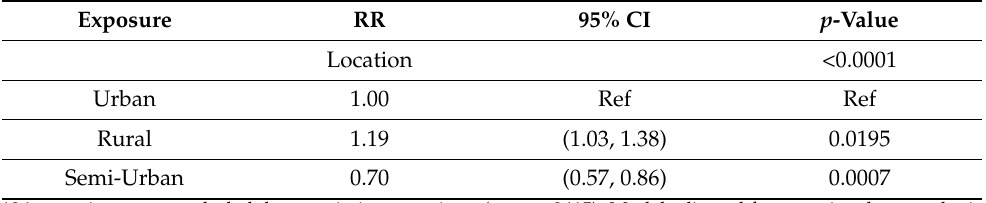
Table 4. Association between geographical location and narratives addressing sexual misconduct.